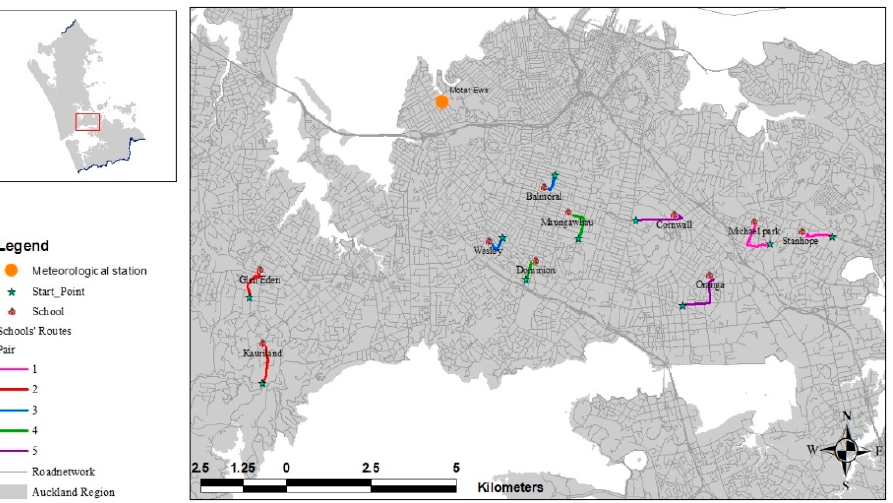
Figure 1. Map of the routes for Pairs 1 to 5. The green stars represent the starting points of each route. Schools are represented as red houses. Orange dot represents the meteorological station.